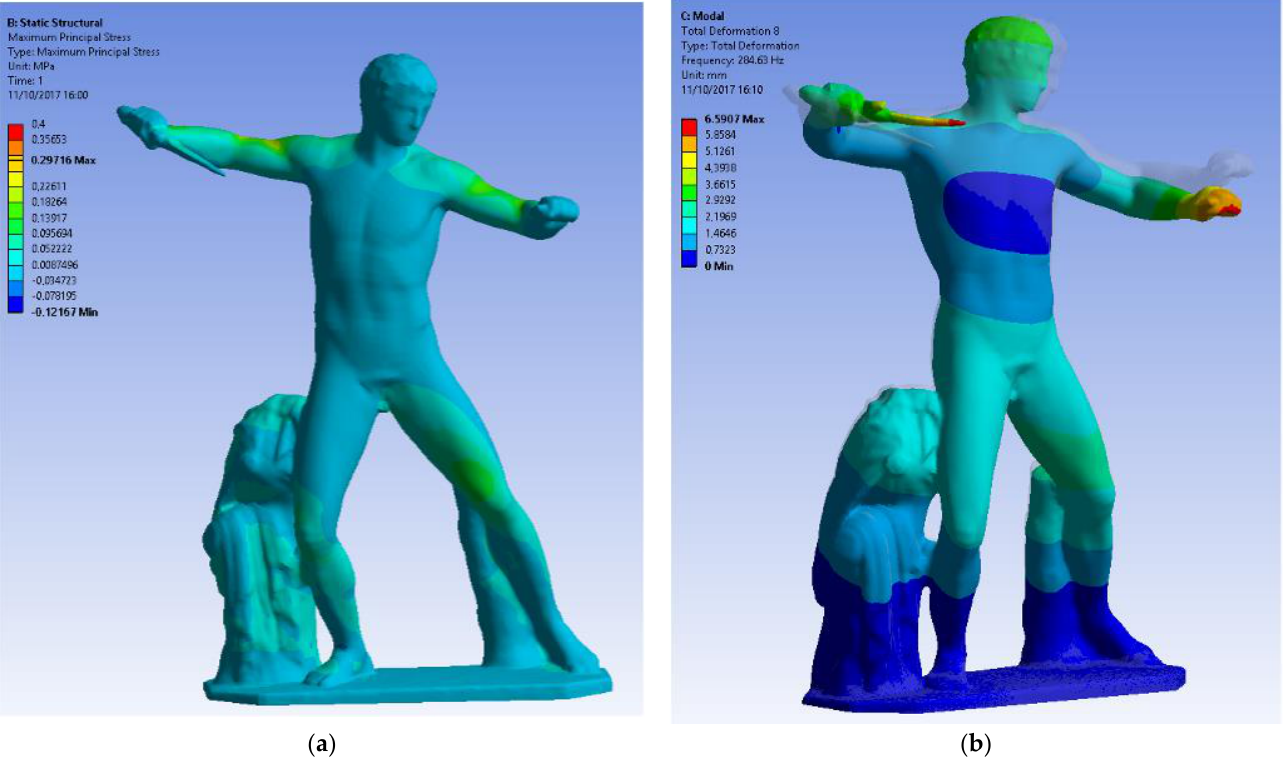
Figure 15. The static structural analysis imposing ( a ) the max principal stress under gravity on the – Z axis and ( b ) the modal analysis for the statue of the gladiator. –Z axis and ( b ) the modal analysis for the statue of the